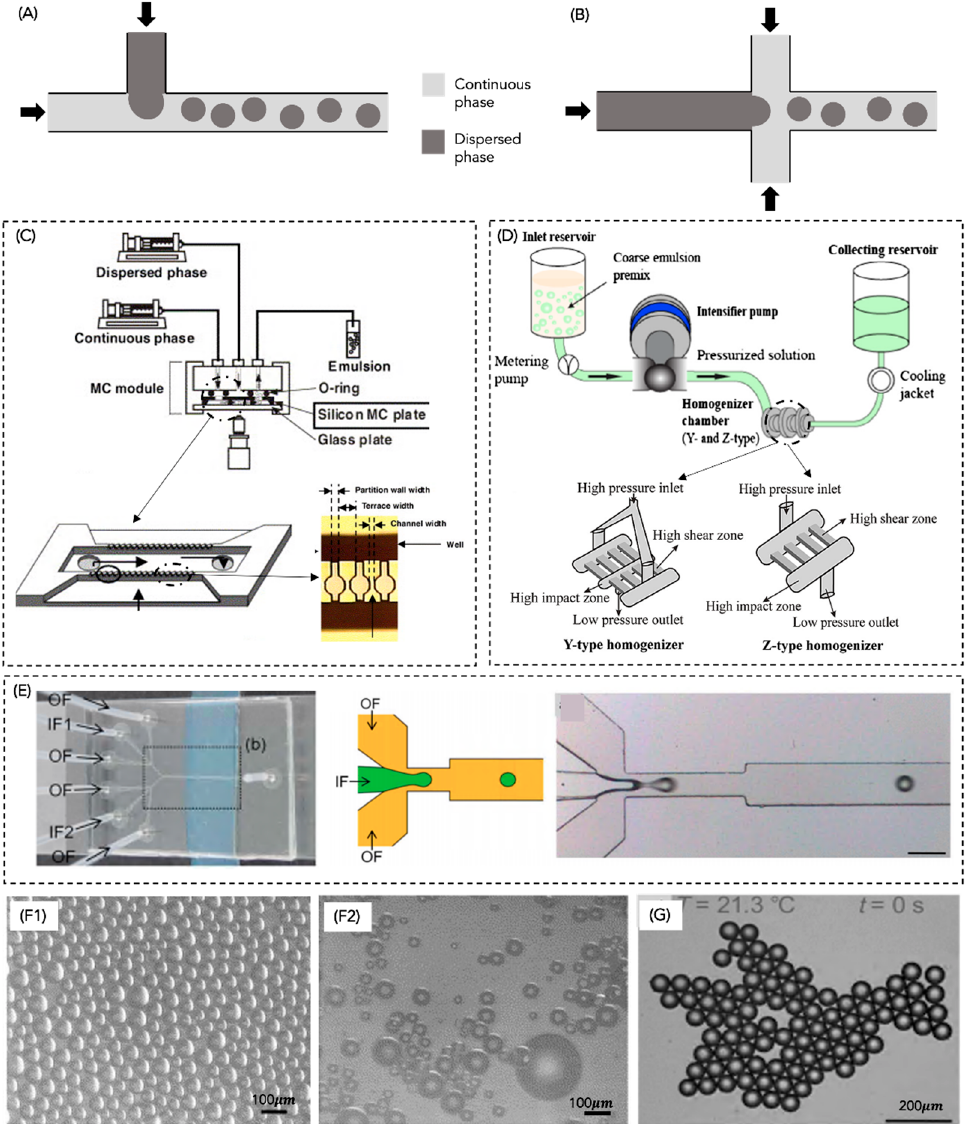
Figure 7. Schematisation of microfluidizers: ( A ) T-junction and ( B ) flow-focusing. Microfluidic technologies used in PE production (( C ) [89], ( D ) [149] and ( E ) [150]). Some optical images of PEs obtained from microfluidizers: ( F1 ) PE obtained from microfluidic device ( C ), and ( G ) PE obtained from microfluidic device E. ( F1 , F2 ) compare PEs produced by microfluidic device and rotor-stator, respectively. (Reprinted from [89], Copyright (2005), with permission from Elsevier; Reprinted from [149], Copyright (2016), with permission from Elsevier; Reprinted from [150], Copyright (2016), with permission from the Royal Society of Chemistry).